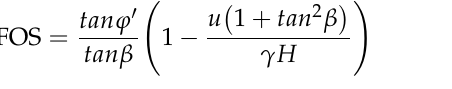
Table 6. The statistical parameters of random variable for infinite slope with pore pressure. Random Variable Distribution Mean Standard Deviation tan β